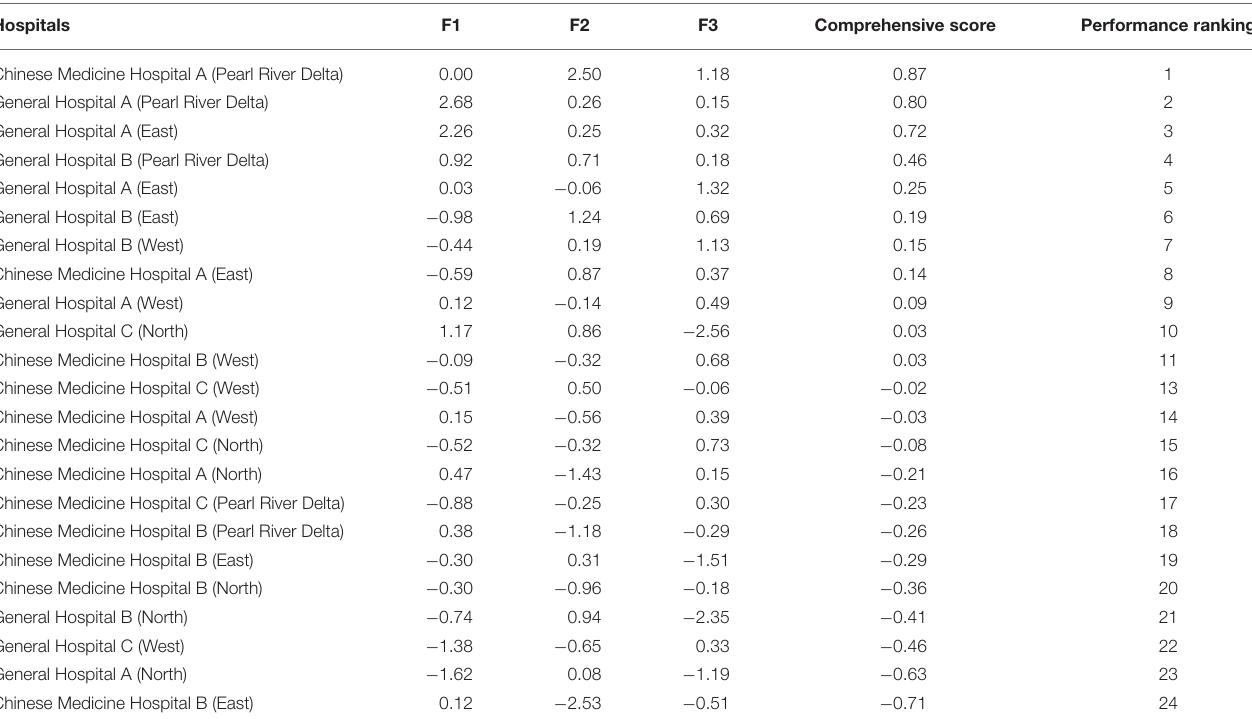
TABLE 5 | Twenty-four hospital performance rankings.